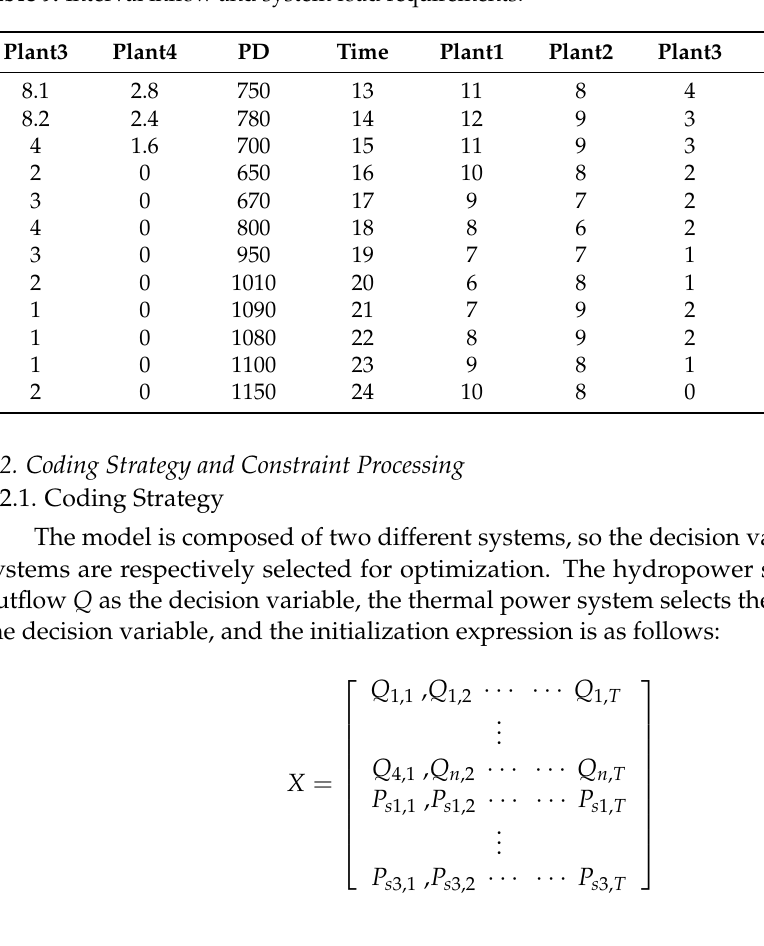
Figure 3. System structure diagram. Table 9. Interval inflow and system load